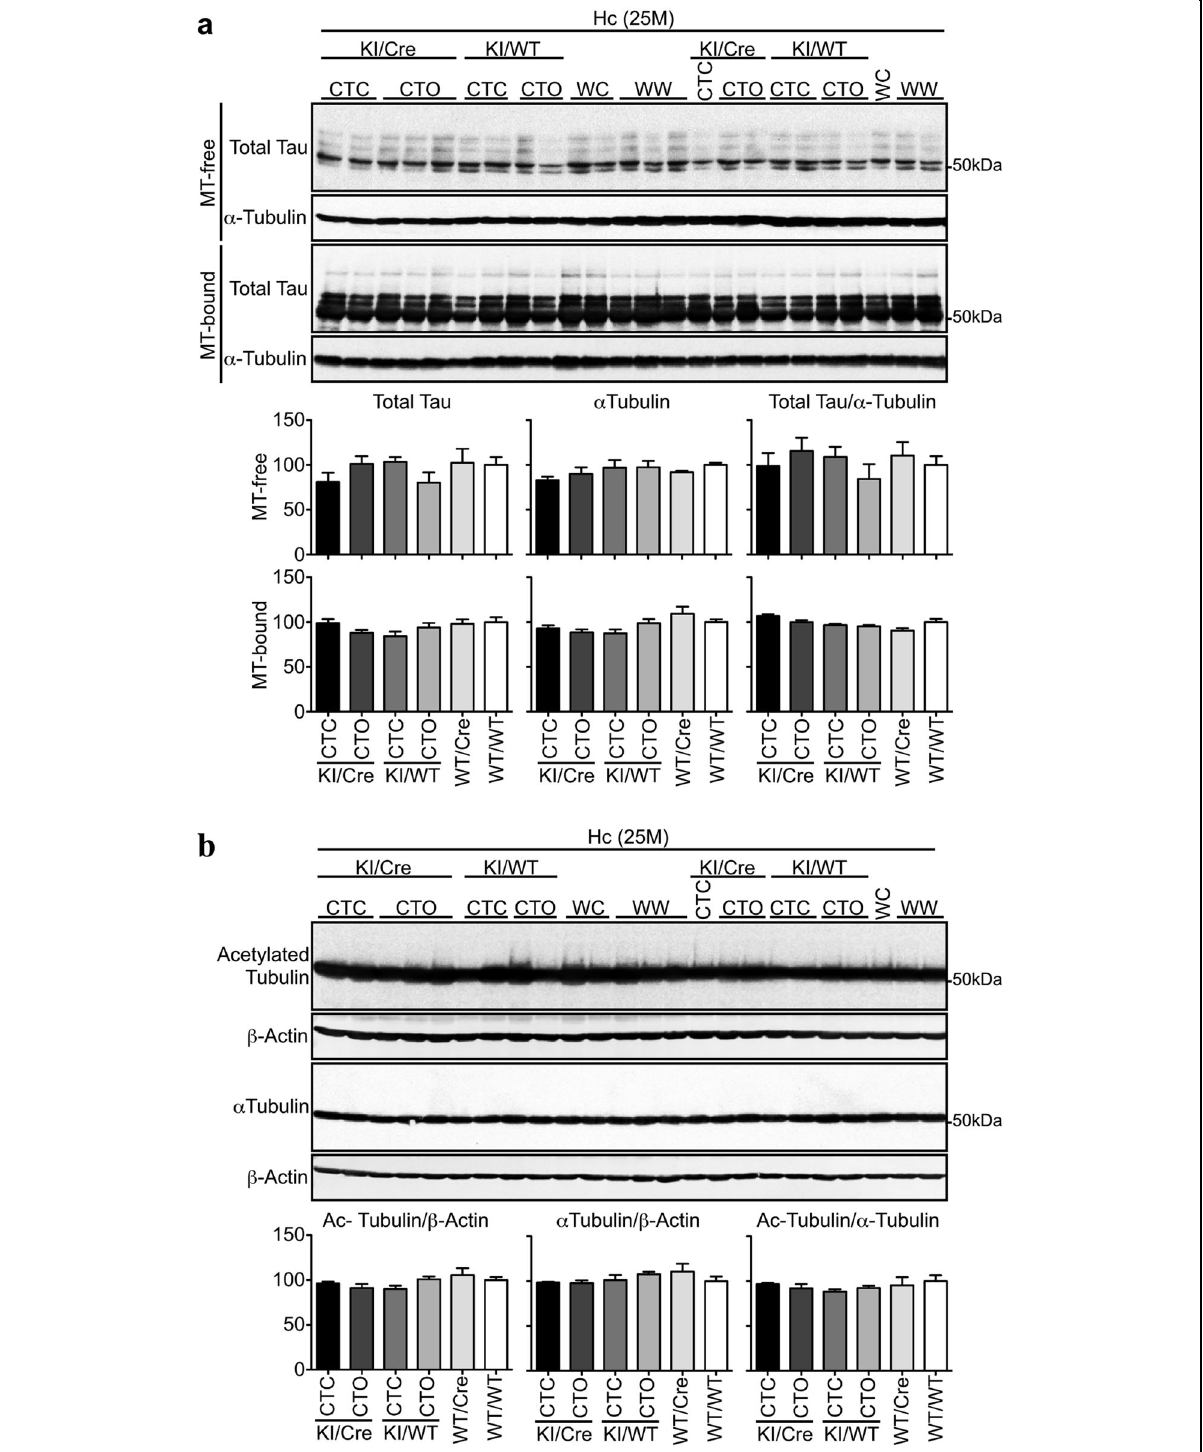
Fig. 7 Tau binding to microtubules is maintained in the hippocampus of old CTC KI/Cre mice. a Western blot analyses and quanti fi cations of total Tau and α -Tubulin in MT-free and MT-bound protein fractions from the hippocampus (Hc) of 25-month-old CTC KI/Cre ( n = 3), CTO KI/Cre ( n = 5), CTC KI/WT ( n = 4), CTO KI/WT ( n = 4), WT/Cre ( n = 3) and WT/WT ( n = 5). b Western blot of 10 μ g total proteins from the hippocampus of 25- month-old CTC KI/Cre ( n = 3), CTO KI/Cre ( n = 5), CTC KI/WT ( n = 4), CTO KI/WT ( n = 4), WT/Cre ( n = 3), and WT/WT ( n = 5) with anti-acetylated-Tubulin, anti- α − Tubulin, and anti- β -Actin antibodies. WC: WT/Cre, WW: WT/WT. Data represent the mean±SEM. One-way ANOVA followed by Bonferroni ’ s post-hoc.